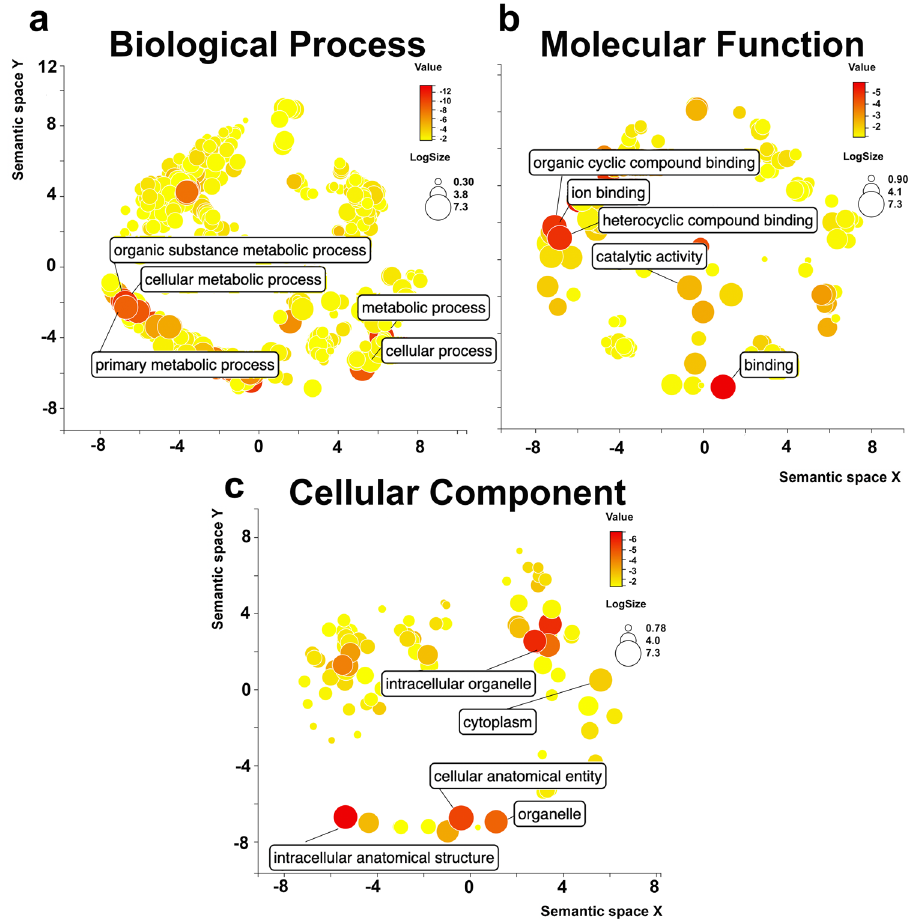
Fig. 2 Gene ontology scatterplot of Ae. aegypti transcripts with m 6 A modi fi cation. The scatterplot shows the cluster representatives of GO terms identi fi ed from Ae. aegypti transcripts with m 6 A modi fi cation generated by Revigo. These GO terms remained after the redundancy reduction, in a two- dimensional space derived by applying multi-dimensional scaling to a matrix of the GO terms ’ semantic similarities. a Biological process, b molecular function and c cellular